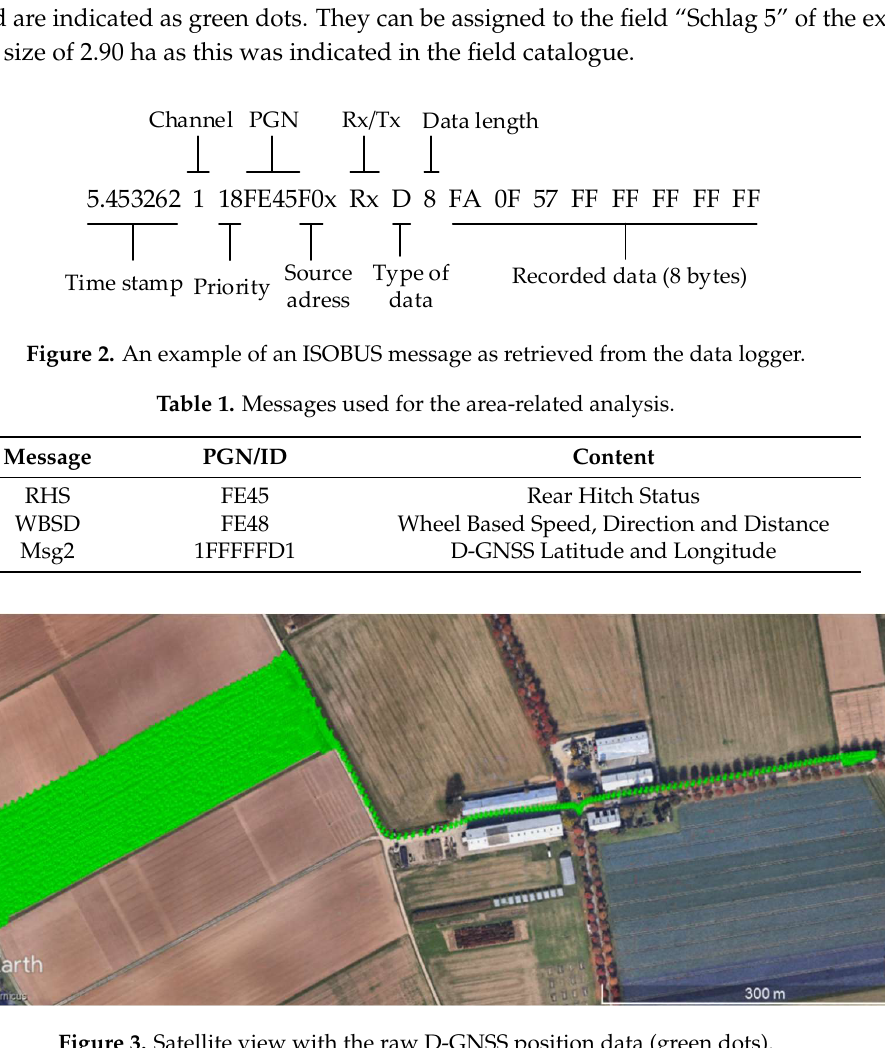
Figure 3. Satellite view with the raw D-GNSS position data (green dots).